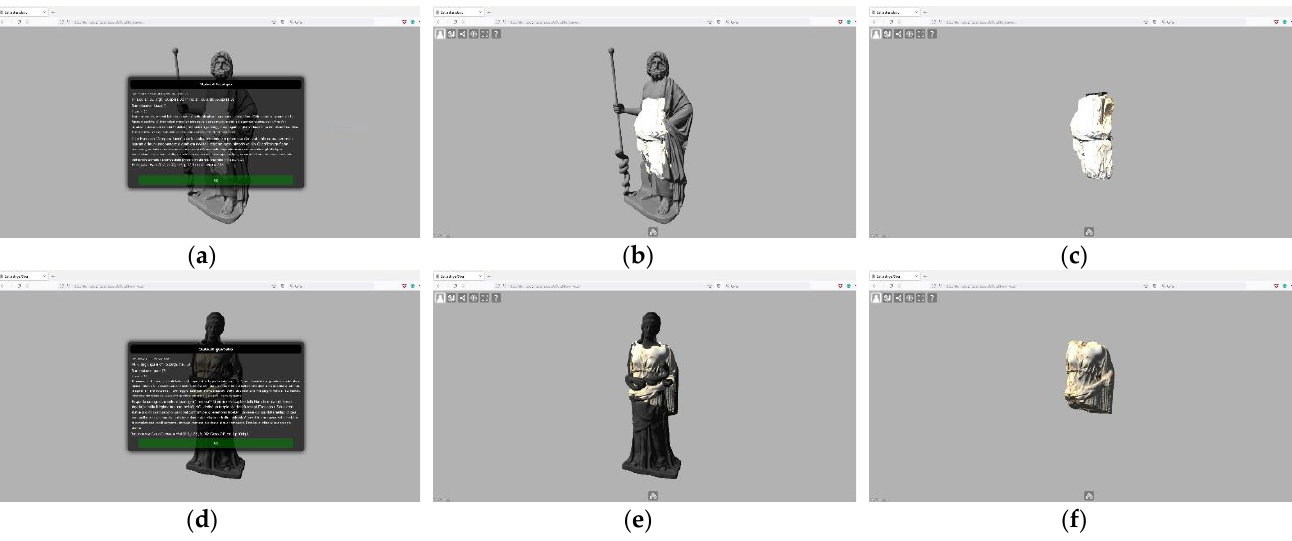
Figure 15. ATON front-end on web browser for computer desktop, textual data sheets ( a , d ), view of the reconstructed models ( b , e ), 3D real models ( c , f ) of the statues of Aesculapius and Hygeia.